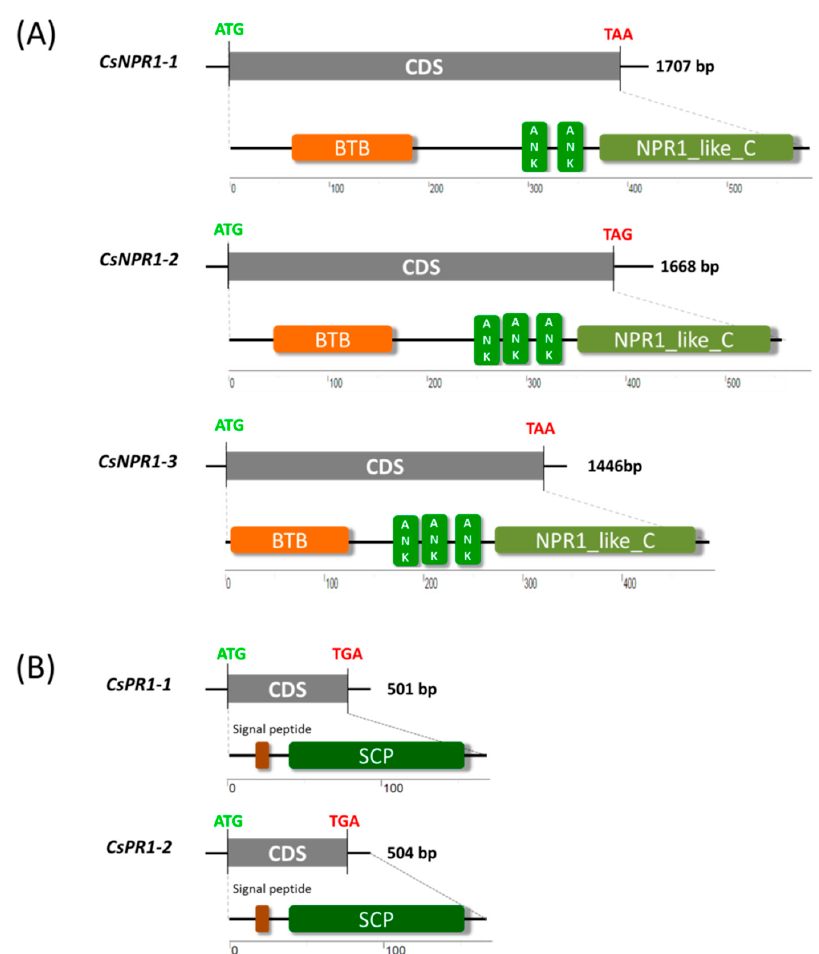
Figure 1. Domain architectures of putative CsNPR1 and CsPR1 proteins in Cymbidium sinense . ( A